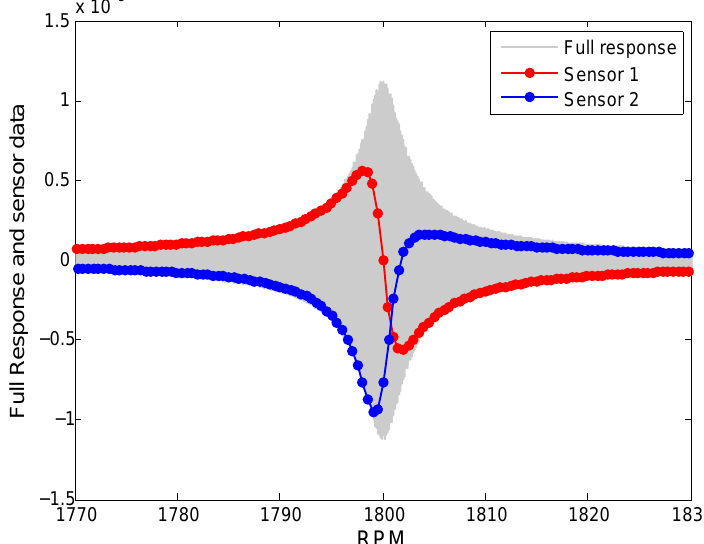
Figure 2. A typical blade response and BTT data during a resonance passage.